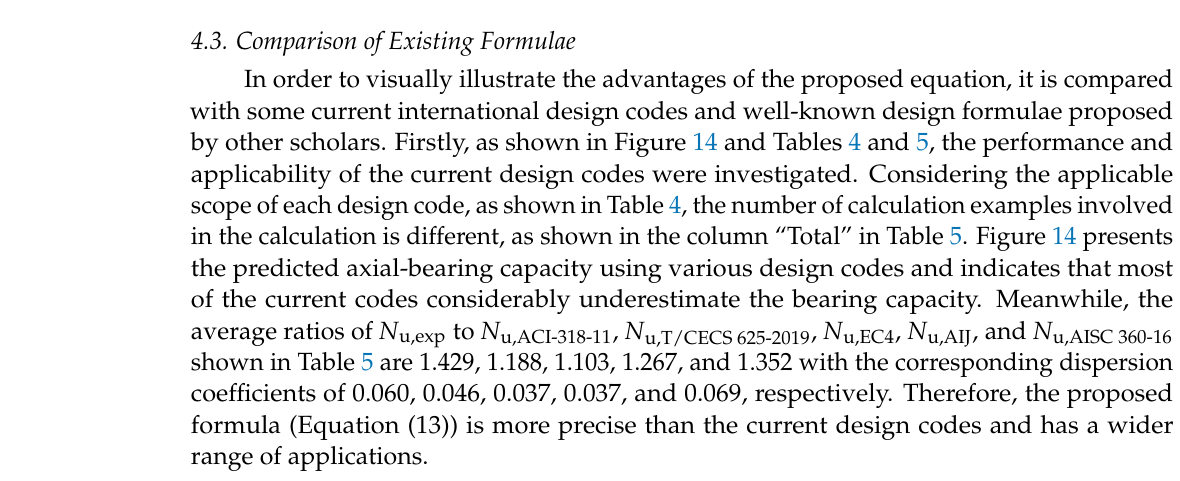
Figure 13. Comparisons of experimental results and FE results with Equation (13): ( a ) comparison of ultimate bearing stress obtained from test results and Equation (13); ( b ) comparison of ultimate bearing stress obtained from FE results and Equation (13); ( c ) comparison of ultimate bearing stress obtained from FE results and test results.